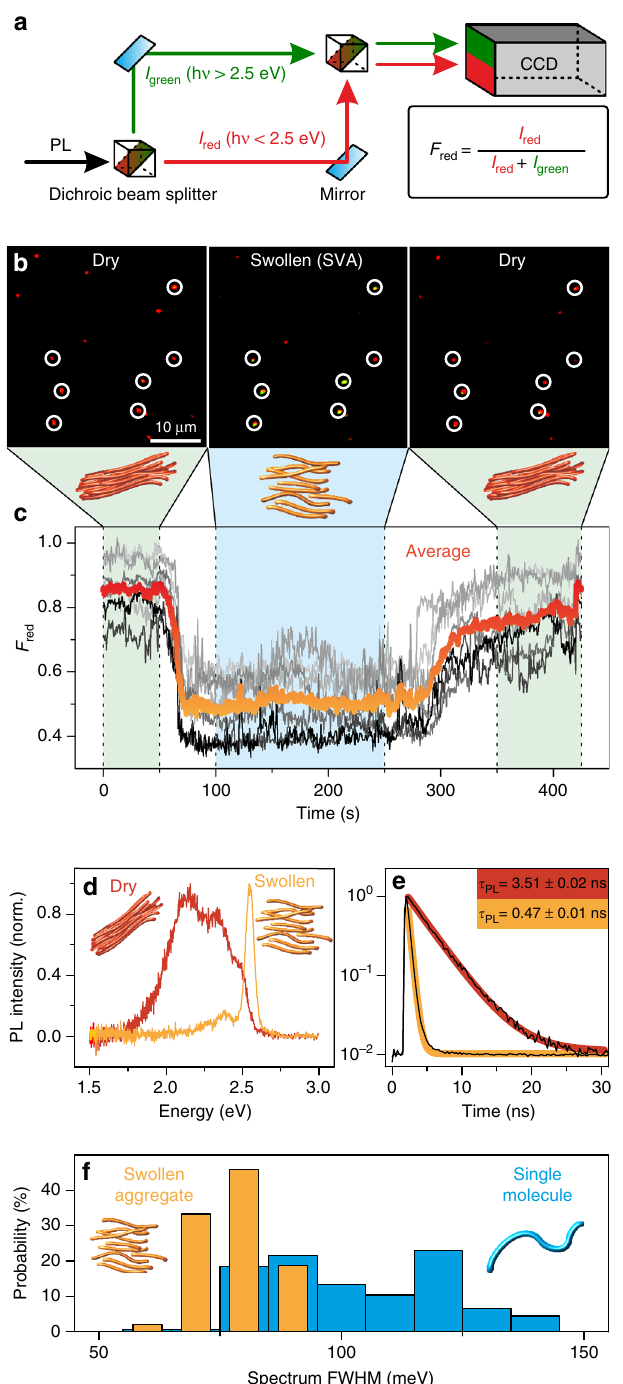
Fig. 2 Switching between H-type and J-type coupling using solvent vapor annealing. a Schematic illustrating the splitting of single-spot PL with a dual-view unit into two detection channels, for photons with hv > 2.5 eV (denoted I green ) and hv < 2.5 eV (denoted I red ), and imaging onto different areas on the same CCD camera. The fraction of red emission for each single spot is de fi ned as F red . b Accumulated wide- fi eld dual-view fl uorescence microscopy images of PPEB-1 aggregates of the same area from a 425 s movie during which the fi lm conditions were changed. The fi rst frame is accumulated during the fi rst 50 s, the second frame at time 100 – 250 s and the last frame at 350 – 425 s. The z -scale is the same for all images. The fi rst and the last frame are measured under ambient conditions and the central frame was obtained during SVA with a 1:4 ratio of toluene and hexane nitrogen vapor. Seven aggregates are marked with white circles. c Evolution of F red values with 500 ms time resolution from the seven aggregates (gray curves) and their average (red/orange curve). d , e Normalized PL spectra and transient PL decays of a single aggregate in a dry (red) and swollen state (orange). The PL decays are fi tted by a single- exponential function with an offset to extract the PL lifetime. f Histograms of the full width at half maximum (FWHM) of the PL spectra of 89 swollen PPEB-1 aggregates (orange) and 131 PPEB-1 molecules (blue) (all individual spectra are shown in Supplementary Fig.